Question: Summarize what this figure shows in one sentence.
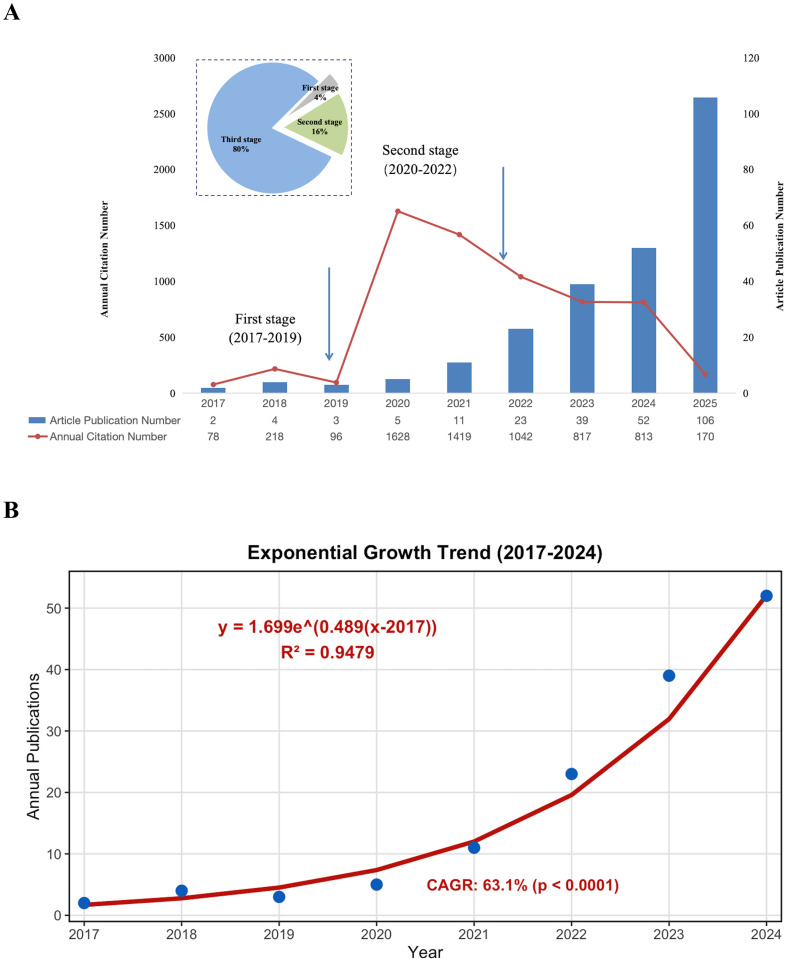
Answer: Temporal trends in publication and citation growth. (A) Annual publications (blue bars) and citation counts (red line) from 2017 to 2025. (B) Exponential growth model fitting of annual publications from 2017 to 2025.